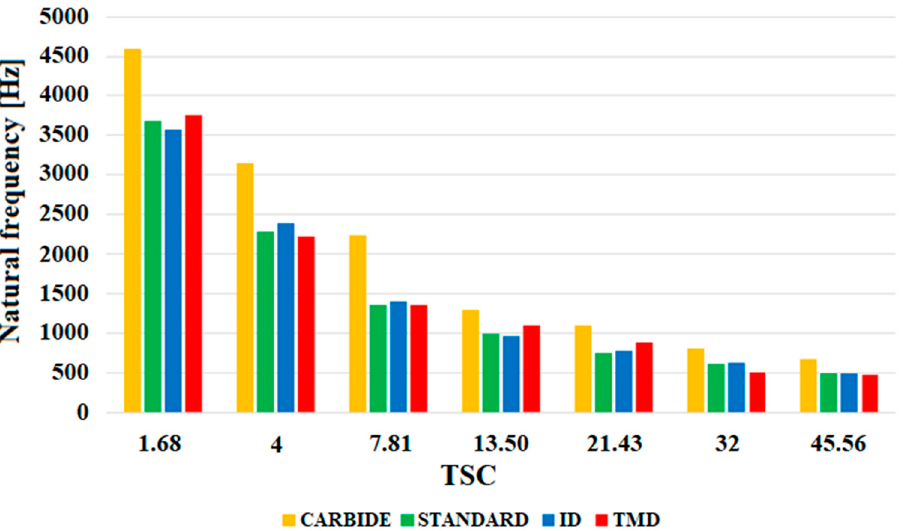
Figure 6. Comparison of the maximum FRF values of the standard, carbide, TMD (Silent Tools), ID ball impact damper bars.